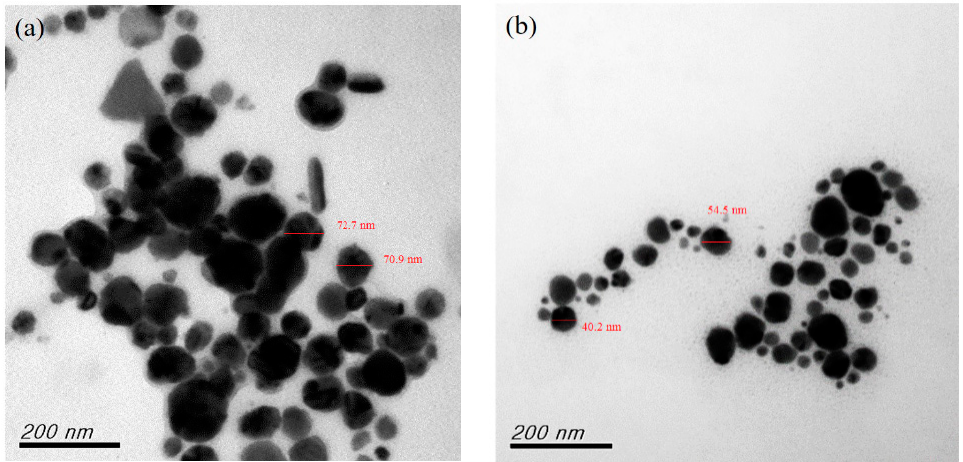
Figure 5. TEM of secondary reduction: ( a ) (AA)/(CuSO 4 ) = 10; ( b ) (AA)/(CuSO 4 ) = 15.